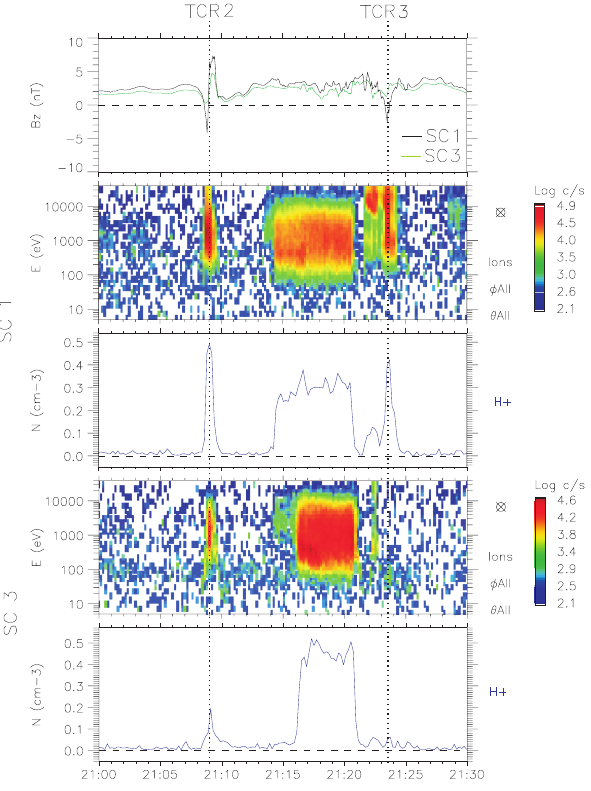
Fig. 6. Cluster magnetic field and plasma observations during the second (21:08:54UT) and third (21:23:34UT) TCR. An enhance- ment of the plasma density for C1 can be seen during the second and third TCR (C2 and C4 show similar behavior as C1, see Slavin et al. (2003c) for details), whereas C3 detects only a small increase.